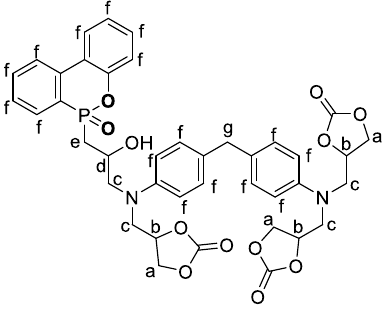
Figure 11. MBDAC-DOPO structure.